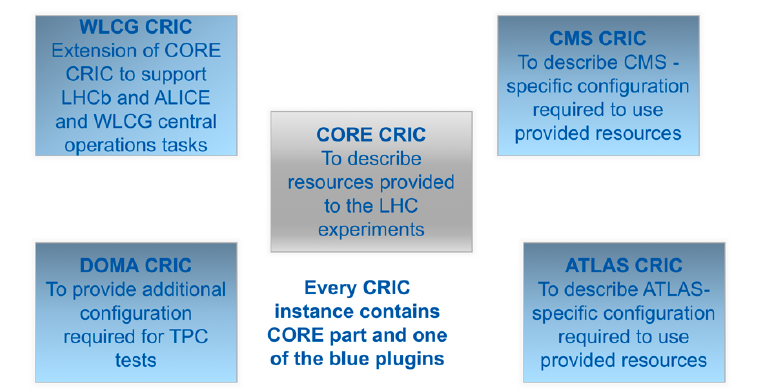
Fig. 2. Structure of the CRIC